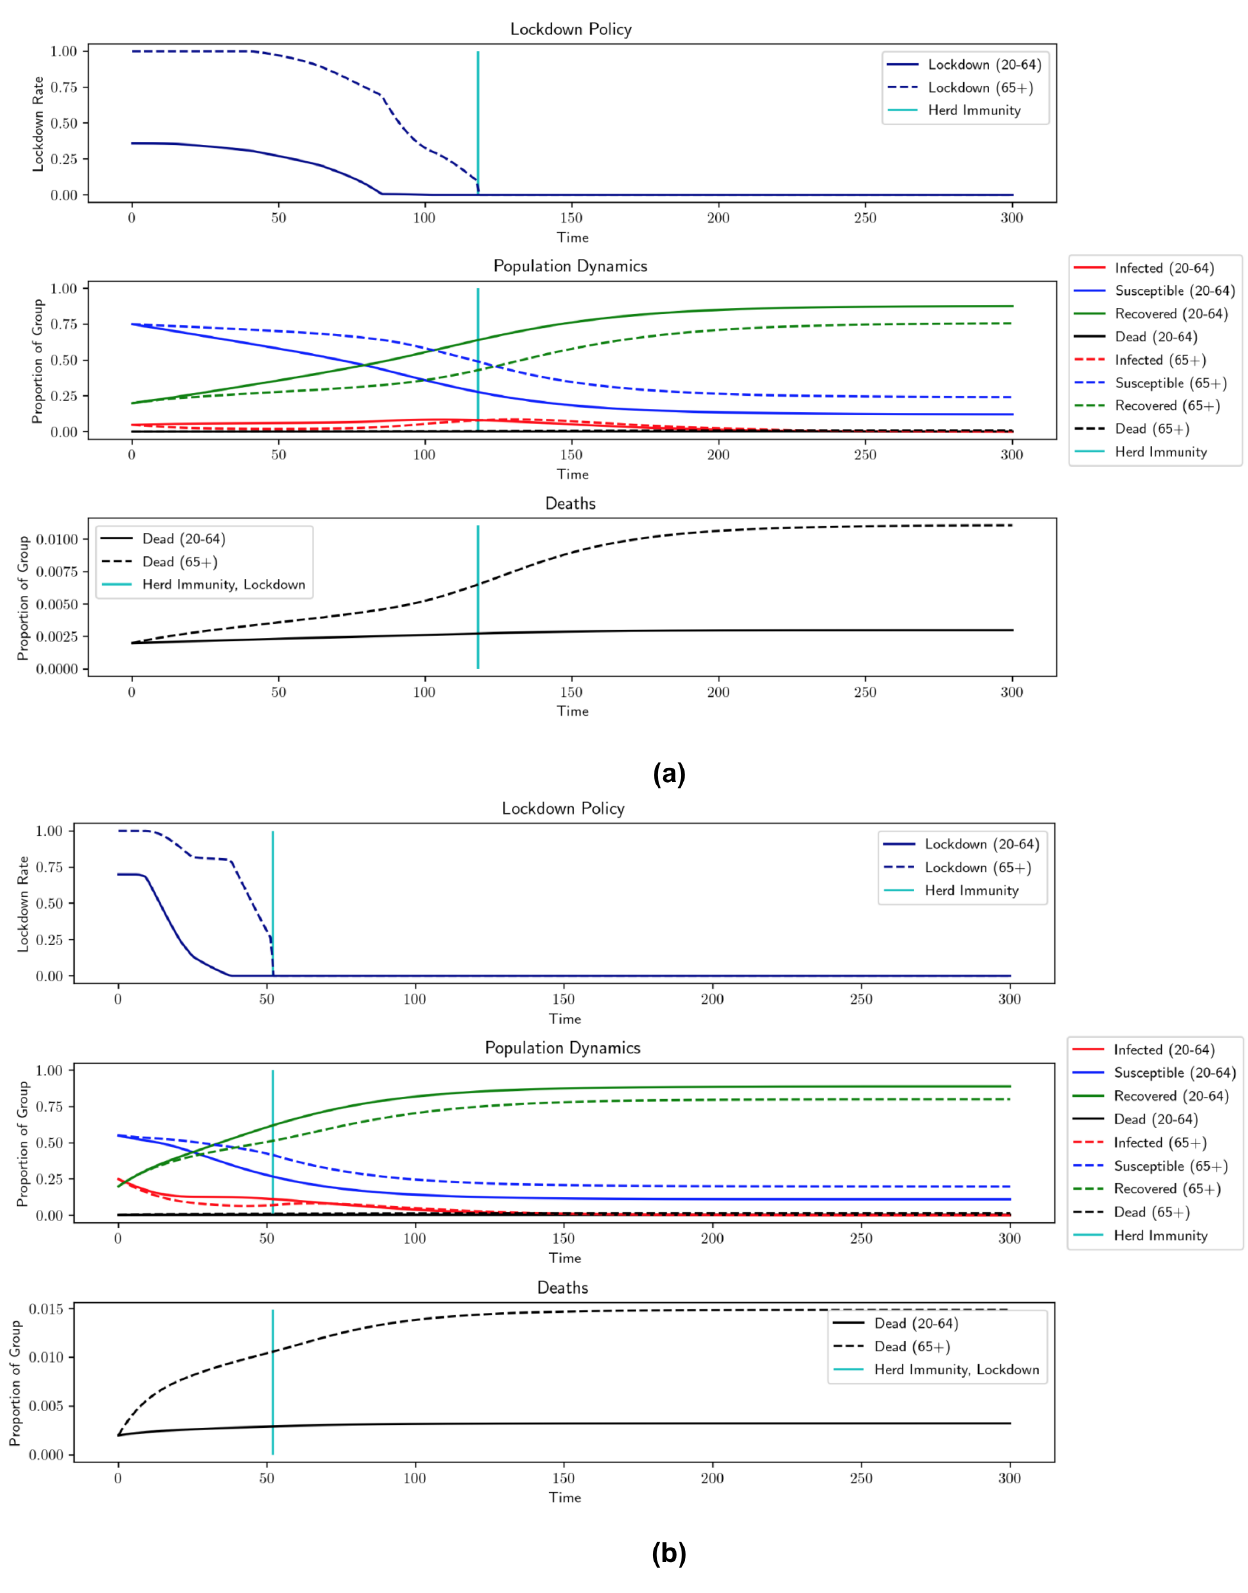
Figure 7. Results for varied initial conditions using benchmark parameters. ( a ) S 0 = 74.8%, I 0 = 5%, R 0 = 20%, D 0 =